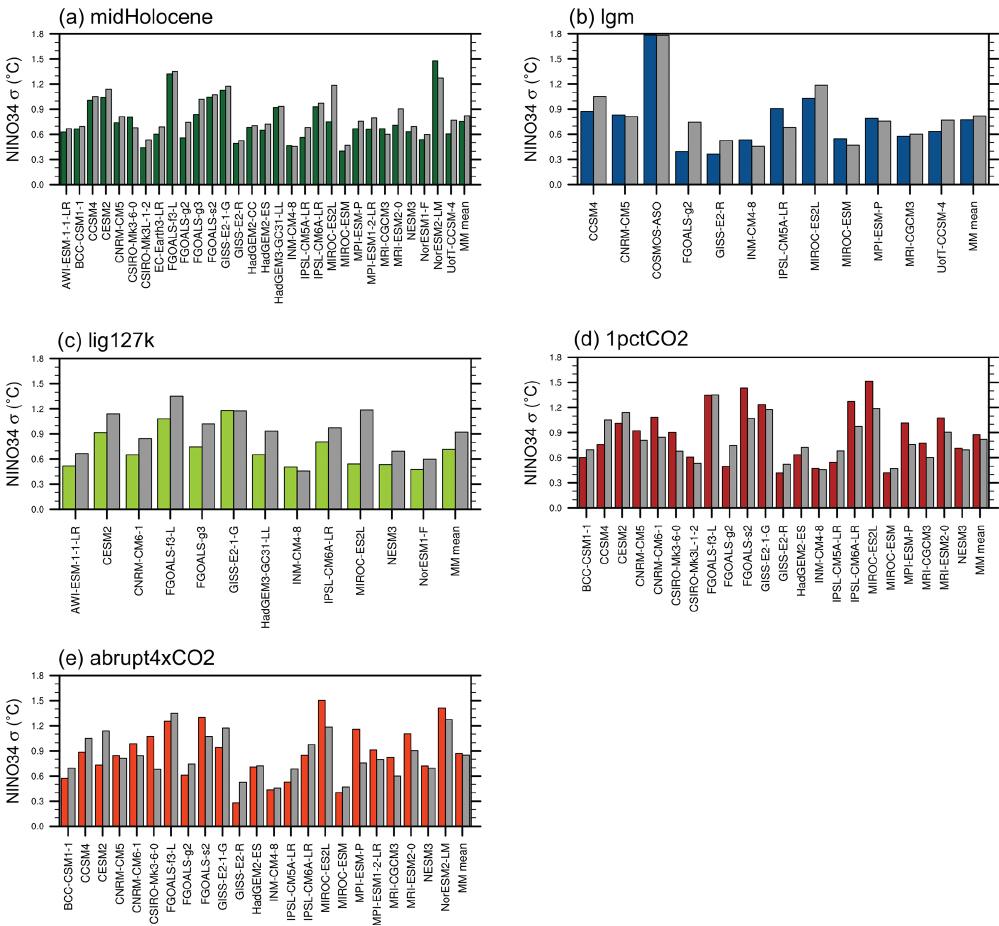
Figure 8. Amplitude of ENSO measured from standard deviation of NINO3.4 index ( ◦ C) in piControl simulations (grey bars) and (a) mid- Holocene (dark green bars), (b) lgm (blue bars), (c) lig127k (light green bars), (d) 1pctCO2 (dark red bars), and (e) abrupt4xCO2 (light red bars) simulations. Model names are given below plots. Multi-model (MM) mean is also